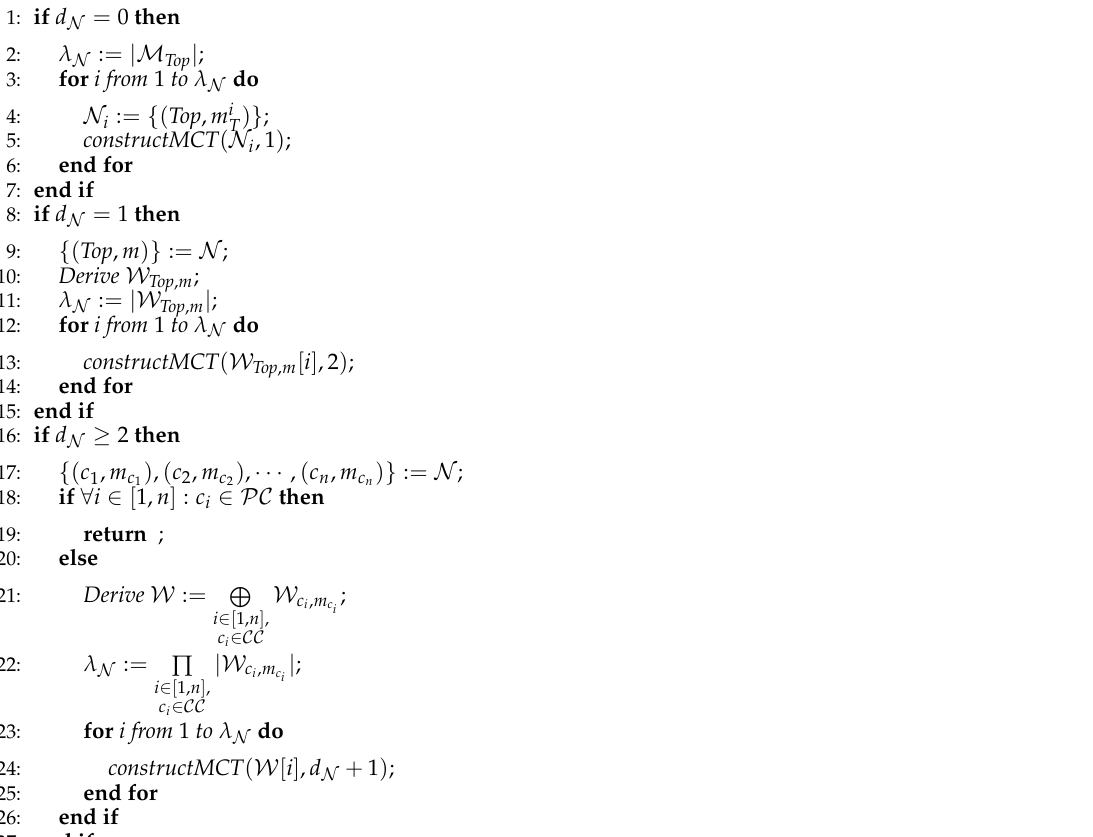
Algorithm 1 constructMCT ( N , d N )